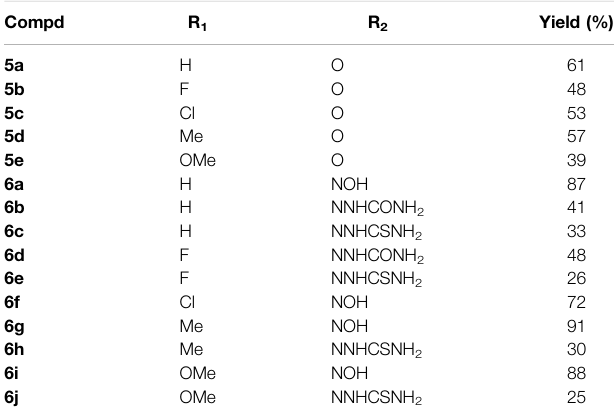
TABLE 1 | Chemical structures and yields of dihydroartemisinin-isatin hybrids 5a- e and 6a-j